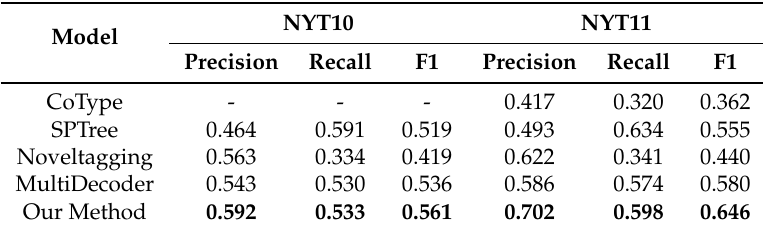
Table 3. Comparison of results of our model and baselines in NYT10 and NYT11 datasets.